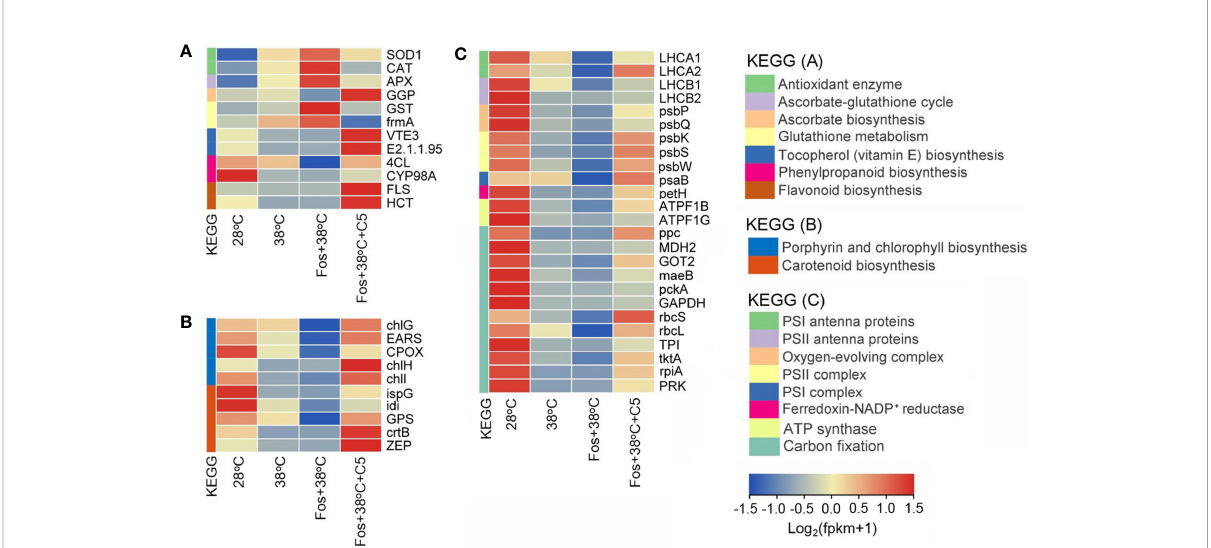
FIGURE 6 Effects of camphor on gene expression in antioxidation (A) , photosynthetic pigment biosynthesis (B) , and photosynthetic abilities (C) in camphor chemotype of C . camphora (CmR). 28°C, 38°C, and Fos+38°C: CmR was treated with normal temperature, high temperature, and high temperature with fosmidomycin (Fos) pretreatment, respectively. Fos+38°C+C5: CmR blocked monoterpene synthesis with Fos was fumigated with 5 m M camphor at 38°C. KEGG: Kyoto encyclopedia of genes and genomes pathways. The heatmap was drawn using the FPKM (fragments per kilobase per million mapped reads) by using the software R packages pheatmap 1.0.12. Means (n = 3) are